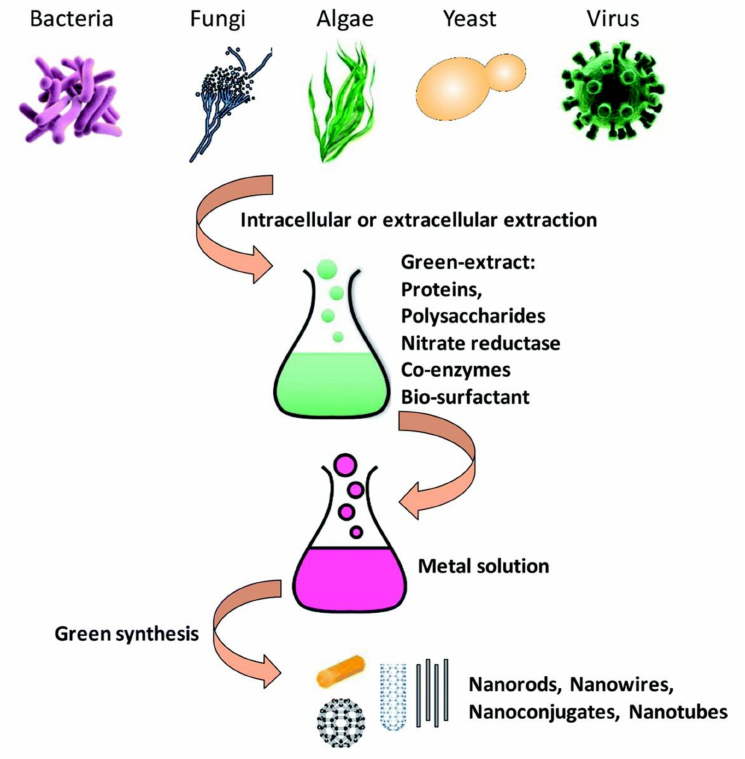
Figure 3. Schematic of metal nanoparticle synthesis by microorganisms